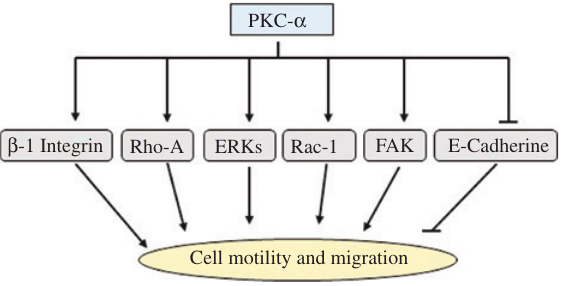
Figure 5: Possible interaction of PKC- α with various factors to control cell motility and